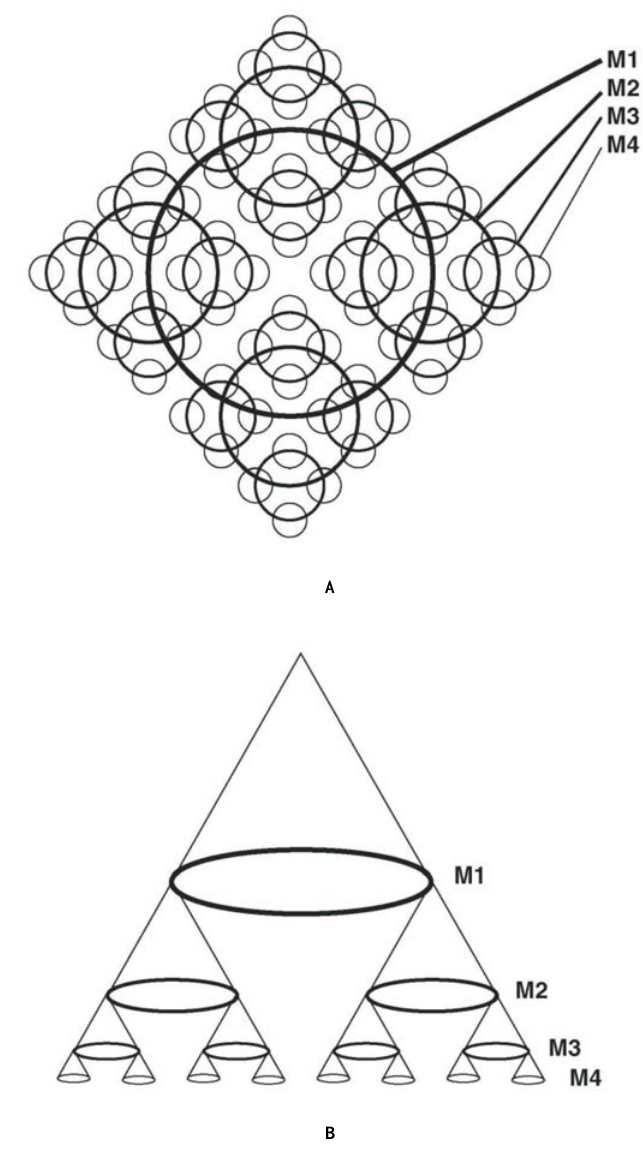
FIGURE 1. This figure gives a generalized representation of the morphogenesis as complex bifurcation. First, the zygote is created. This divides — eventually only by division of the core as with the insects — to form a heap of cells. This again divides (as, for instance, with Hydra ) and when the new group of cells are suitable enough (variegating between different species), it performs its first organization corresponding to the superior construction of the organism (establishment of the germinal layer). After this, the embryo begins to grow and the germinal layers are divided into organ systems. These again, are divided into organs that again are divided into theirs structures on many levels. This goes on until all details of the organism are specified. All these levels of organization are specified in A and B as M1, M2, etc.